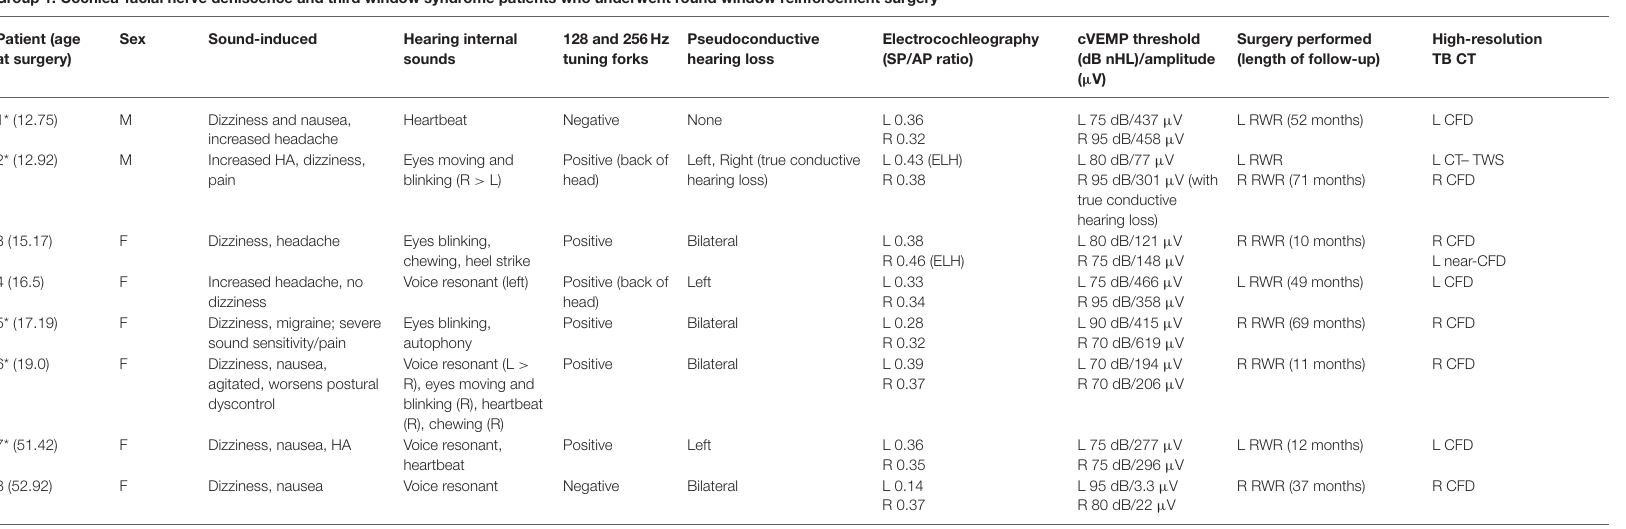
Group 2: Cochlea-facial nerve dehiscence and third window syndrome patients who did not undergo round window reinforcement surgery Patient (age at presentation)